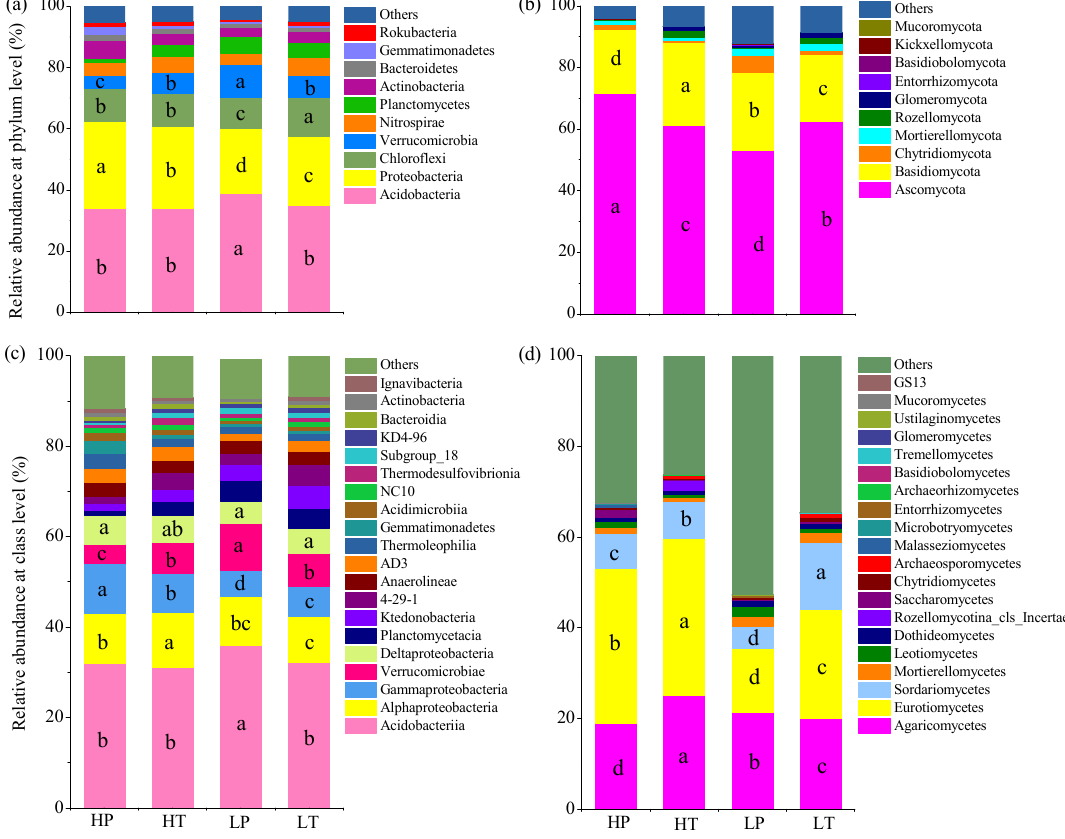
Figure 3. Relative abundances of soil microbial communities at phylum and class levels in different groups. ( a ) Bacteria at phylum level; ( b ) fungi at phylum level; ( c ) bacteria at class level; ( d ) fungi at class level. HP denotes P. hydropiper community at high level above the water table, HT indicates T. lutarioriparia community at high level above the water table, LP signifies P. hydropiper community at low level above the water table, and LT refers to T. lutarioriparia community at low level above the water table. Different lowercase letters represent significant differences among groups ( p < 0.05).